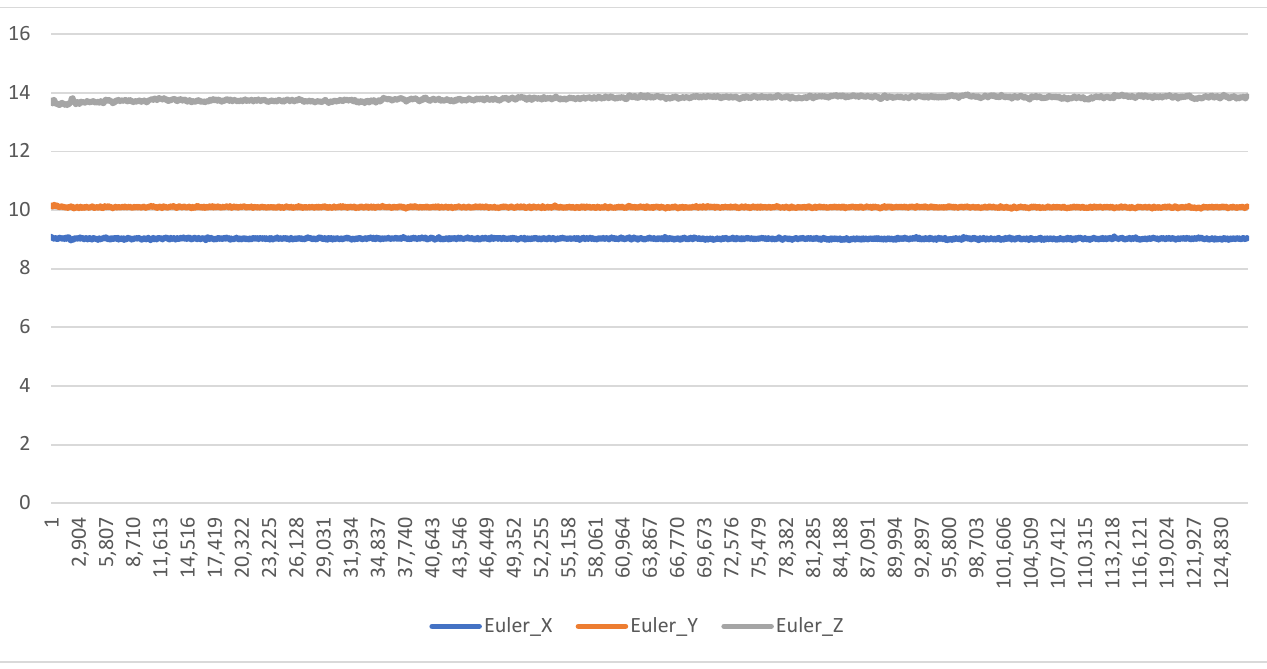
Figure 4. Orientation (in degrees) during Static Drift Testing, demonstrating no change in orientation during an 8 h recording.